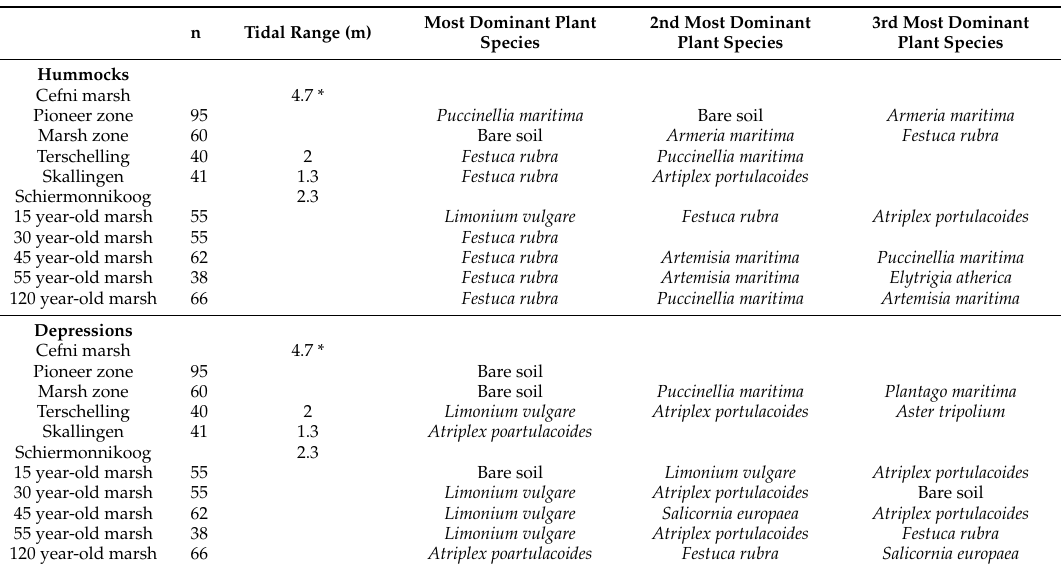
Table 1. Characteristics and sampling effort at marsh